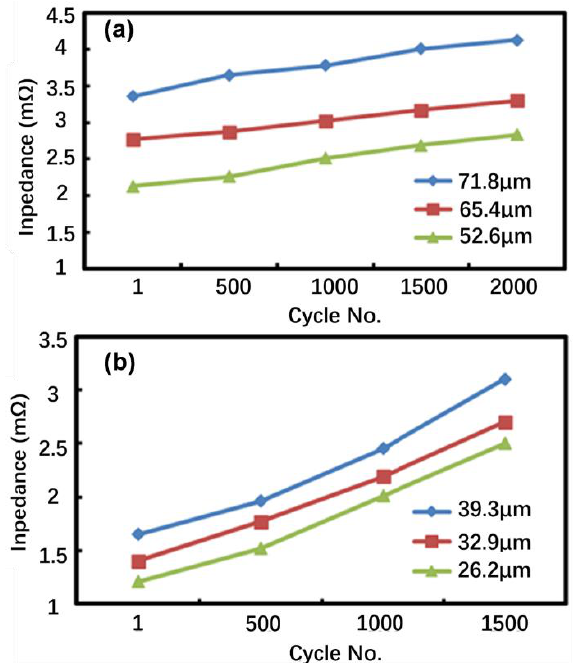
Figure 10. Relation between electrode thickness and AC internal resistance of pouch cell. ( a ) The electrode thickness of the cell is 71.8 µ m, 65.4 µ m and 52.6 µ m, respectively, ( b ) The electrode thickness of the cell is 39.3 µ m, 32.9 µ m and 26.2 µ m, respectively.